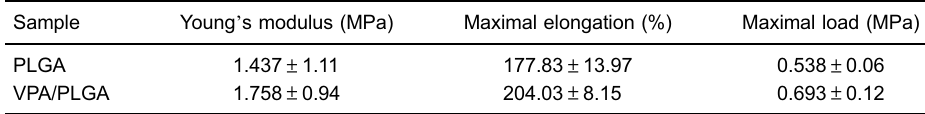
Table 1. Young ’ s Modulus (MPa), maximal elongation (%) under the applied force, and the maximal load